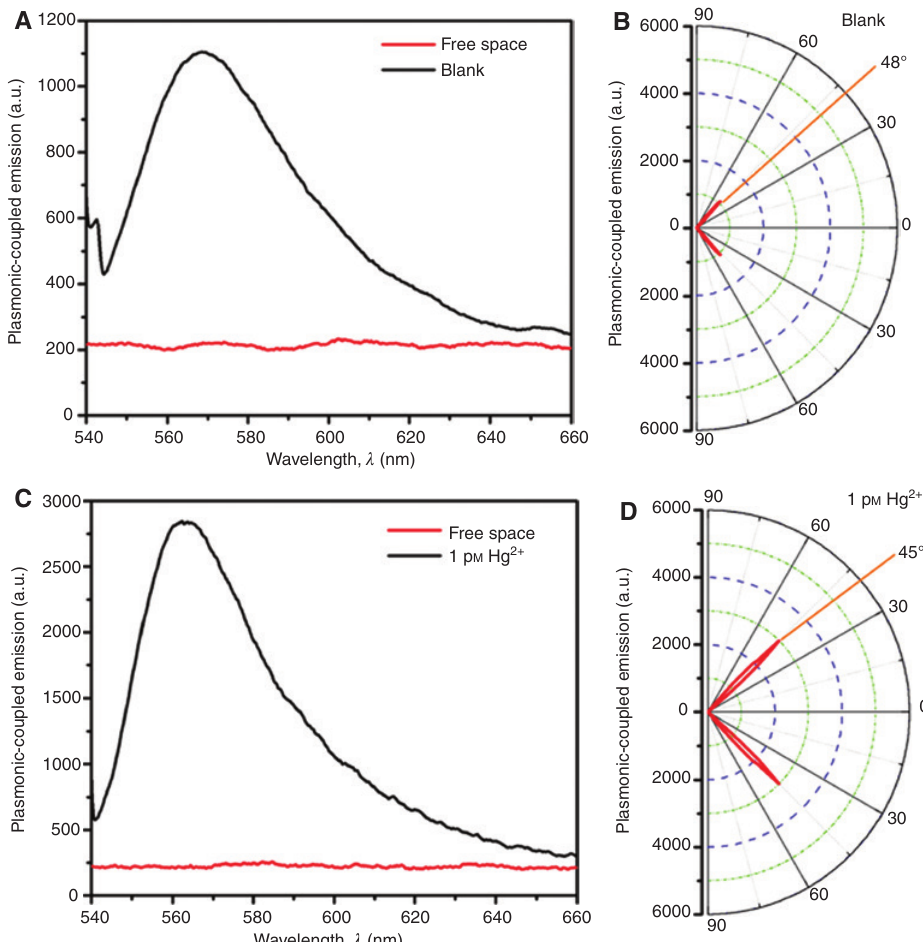
Figure 3: (A) SPCE and FS intensity of Rh6G D in the absence of Hg 2 + ; (C) SPCE and FS intensity of Rh6G D in the presence of Hg 2 + ; and SPCE radial plots for (B) blank and (D) 1 pm Hg 2 + .